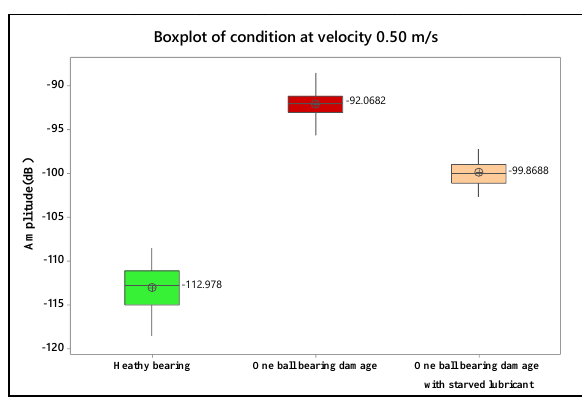
Fig . 8 Frequency domain ( dB ) for velocity 0 . 50 m / s .